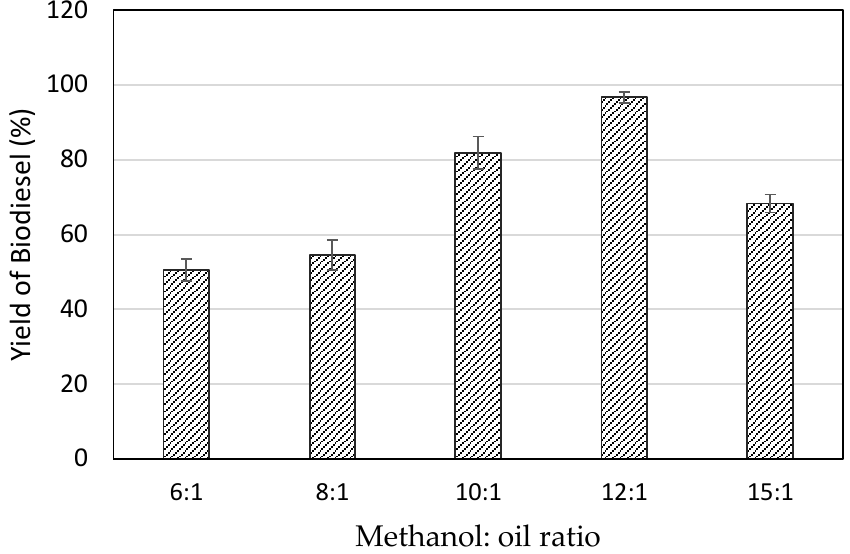
Figure 6. Effect of molar ratio on the biodiesel yield using KOH-impregnated eggshell (20 wt%) catalyst with a catalyst loading of 7 wt% at 60 °C for 60 min. The p -values of ANOVA test was 0.000 ( p < 0.05).